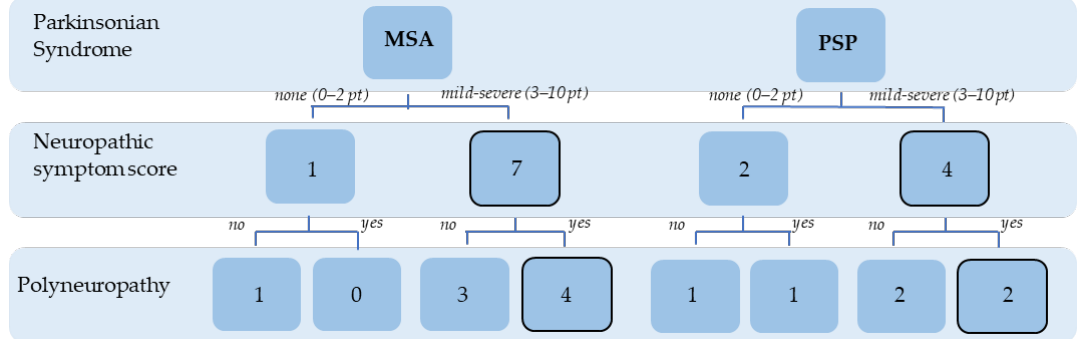
Figure 1. Prevalence of neuropathic symptoms in APS patients in the NSS and electrophysiologically confirmed